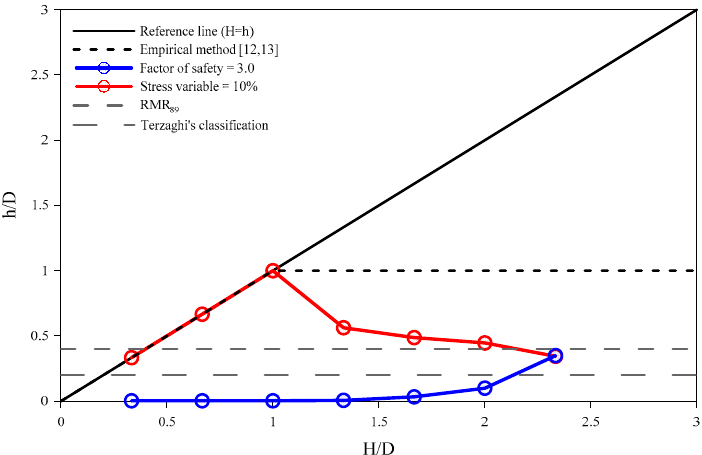
Figure 12. Relation between H / D and h / D for rock mass class III considering the factor of safety and stress variable.